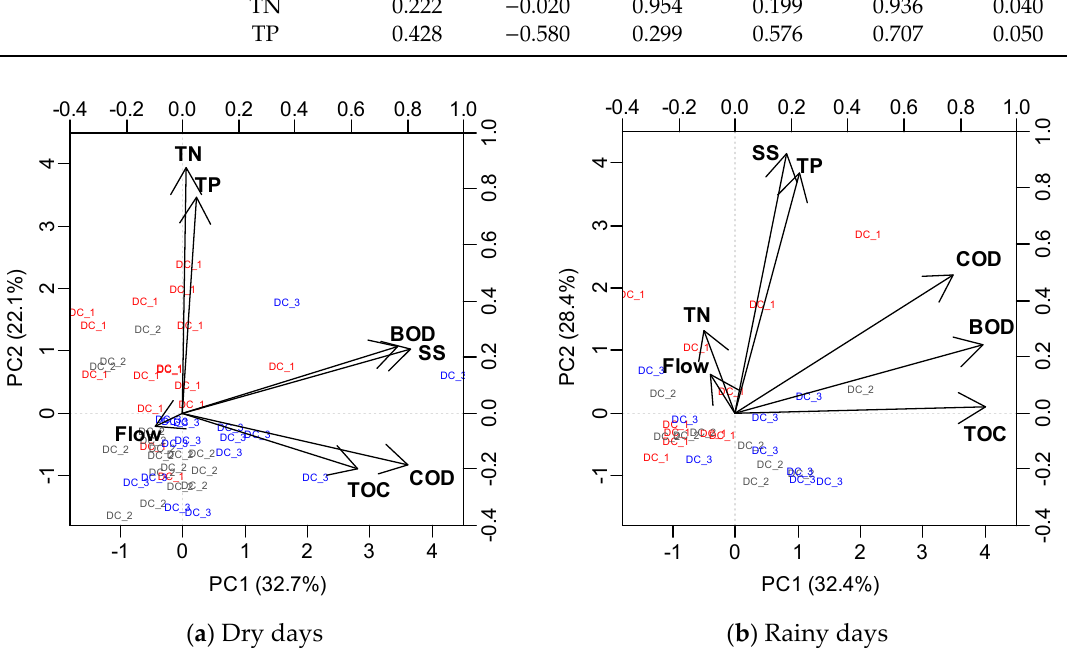
Figure 8. Biplot of principle components for water quality characteristics in Dochoncheon.